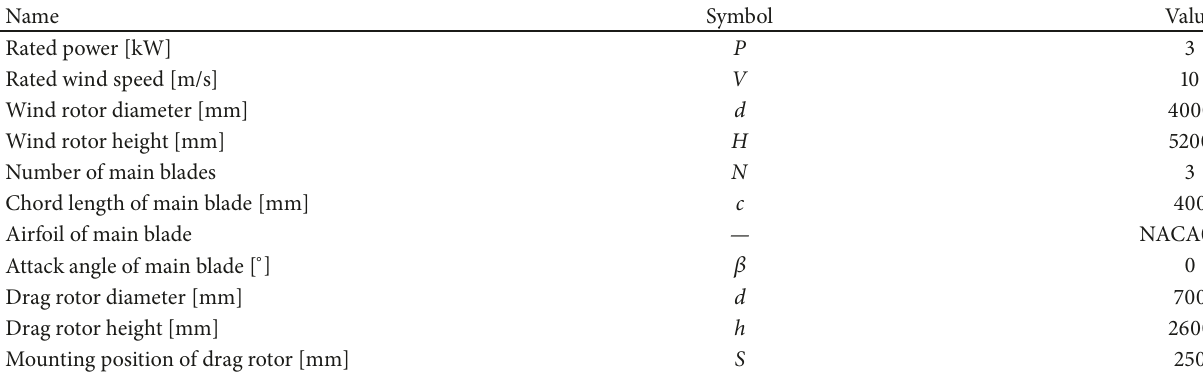
Table 1: Basic structural parameters of LD-VAWT.